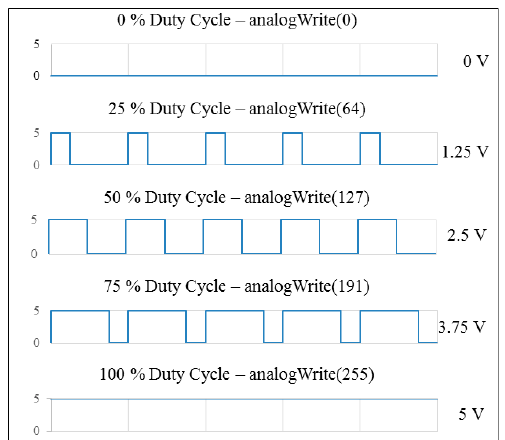
Figure 3. The schematic configuration of the acceleration/brake-by-wire system.